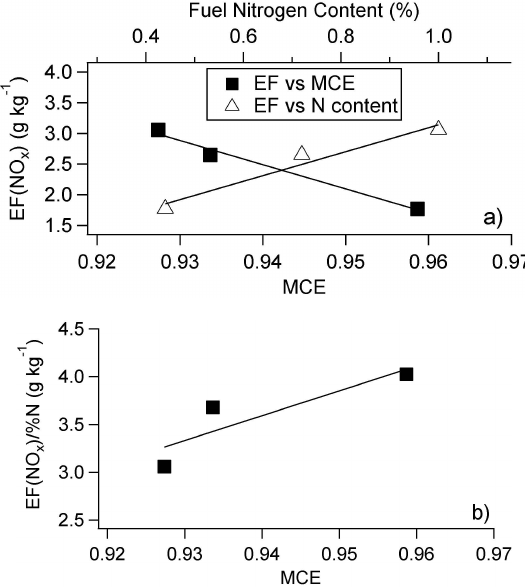
Fig. 4. Dependence of EF(NO x ) on fuel nitrogen content and MCE for chipped understory hardwood, one-year rough and two-year rough from Camp Lejeune. (a) EF(NO x ) as a function of fuel ni- trogen content and MCE. (b) EF(NO x ) normalized by fuel nitrogen content as a function of